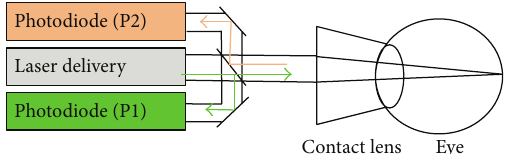
Figure 1: Schematic sketch of the reflectometry. The system con- tained two photodiodes; one of them (P1) detects the laser pulses applied to the fundus, and the other (P2) detects reflected and backscattered light from the retina. As a result, reflectometry can stop laser irradiation appropriately for selective RPE